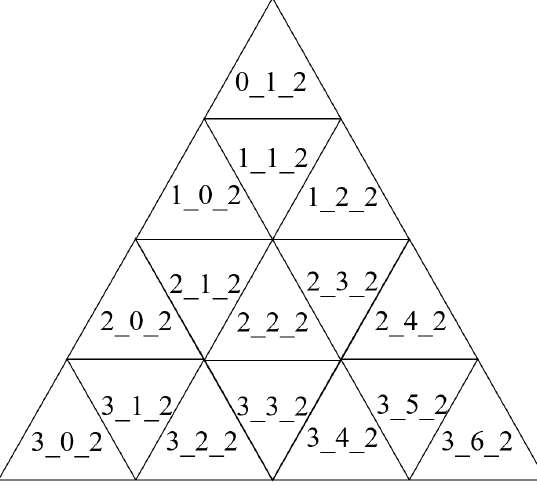
Figure 7. Arithmetic layer encoding method.